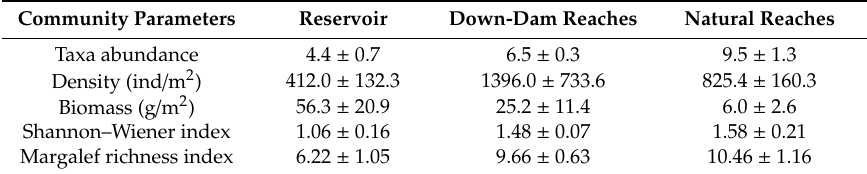
Table 3. Macroinvertebrate structure parameters (Mean ± SD, SD stands for standard deviation) in reservoirs, down-dam reaches, and natural reaches in